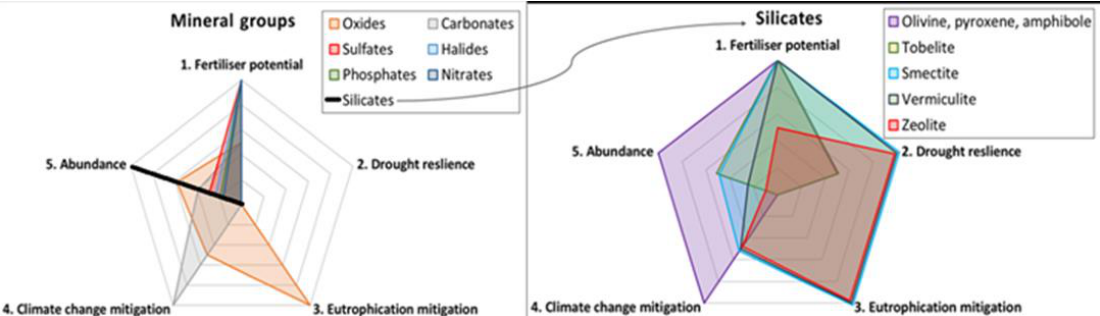
Figure 6. Semi-quantitative expression of key agricultural attributes for the main mineral groups. Note: abundance rankings derived from elemental and mineral crustal abundance data in Reference [17] and Hartmann and Moosdorf [162].